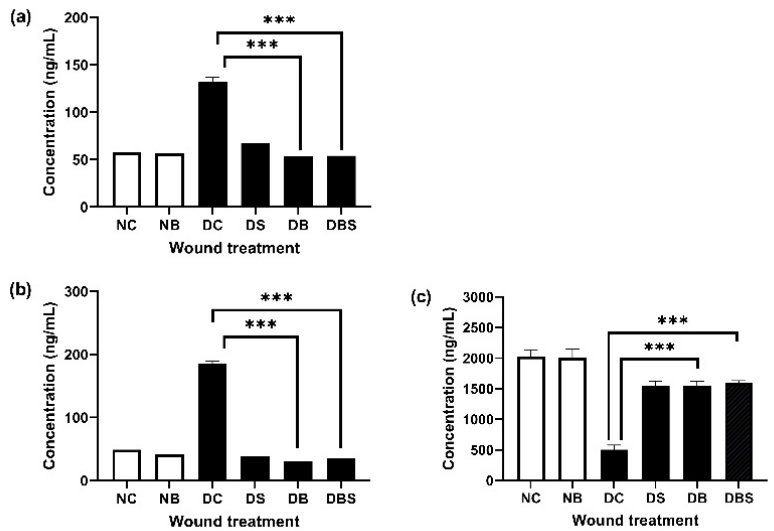
Figure 4. Effects of different treatments on ( a ) TNF- α , ( b ) IL-6, and ( c ) IL-10 in wounded skin. Skin tissues covered with gauze (NC, DC), Suile ointment (DS), bacterial cellulose (NB, DB), and Suile ointment combined with bacterial cellulose (DBS) were removed with a 0.6 cm skin biopsy punch from normal ( n = 36) and diabetic mice ( n = 36) on day 21 after wounding, and the concentrations of inflammatory factors were measured. Bars, means of triplicates ± S.D. (***) p < 0.001, as compared with the relative control group by two-way ANOVA. A purple-blue color in tissue sections after H&E staining indicates the inflammatory state of the tissue [47], while light red, dark red, and dark blue regions after Masson’s trichrome staining represent locations of granulation, re-epithelialization, and collagen deposition, respectively [48,49]. Therefore, both H&E and Masson’s trichrome staining were used to determine the wound recovery status of the diabetic mice. The H&E staining of the wounds of db/db mice treated with gauze is shown in Figure 5a,b. Compared with the bacterial cellulose group, a purple-blue color was only observed in the tissue of the gauze group, indicating that the cells were still in a severe inflammatory state, and loos- ening of the epidermal layer also suggested that the wounds had not completely healed. In the Suile (Figure 5h), bacterial cellulose (Figure 5l), and Suile with bacterial cellulose (Figure 5p) groups, the corresponding Masson’s trichrome staining showed an average epidermal thickness of 4.28 ± 1.16, 12.14 ± 2.27, and 7.86 ± 1.39 µm and an average granu- lation tissue thickness of 40.41 ± 3.16, 128.36 ± 2.18, and 58.57 ± 6.19 µm, respectively. We also observed that the bacterial cellulose group showed more complete collagen formation and deposition (blue region, Figure 5k), while the other groups displayed a looser collagen structure with cavities. The above results indicate that, compared with gauze, bacterial cellulose reduced the degree of inflammation and was more beneficial for the recovery of epidermis and granulation in wounded tissues. In addition, Suile ointment performed better when applied in combination with bacterial cellulose than when applied alone.